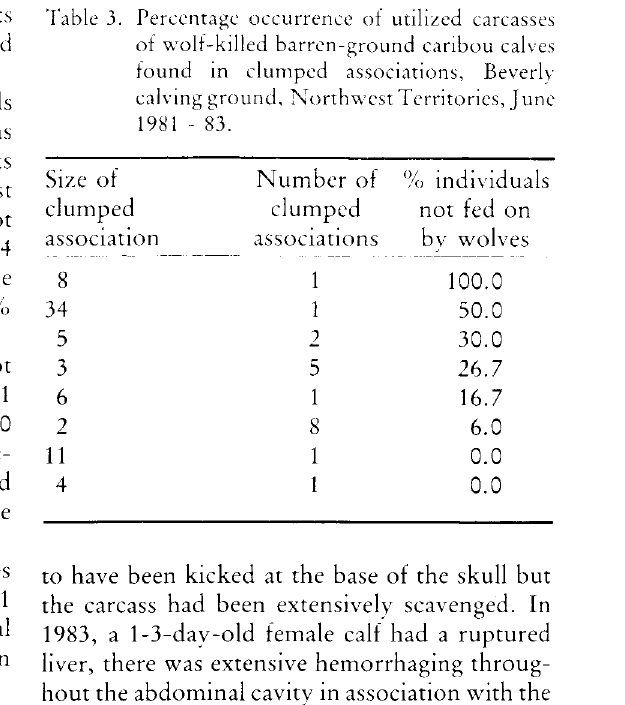
Table 3. Percentage occurrence of utilized